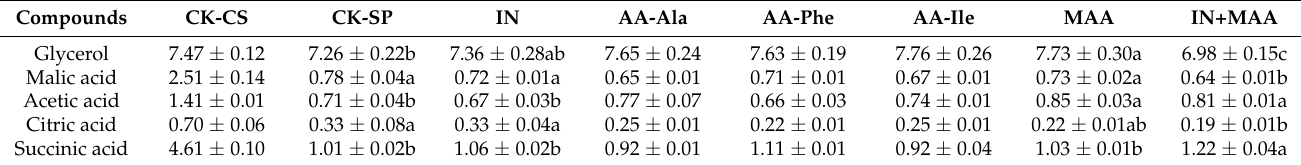
Table 4. Concentrations of extracellular metabolites in wines obtained from different nitrogen nutrient treatments (g/L). Data are mean ± standard deviation. Values displaying different letters within each row are significantly different according to the Duncan test at 95% confidence level. The Duncan test was carried out in columns CK-SP, IN, MAA, and IN+MAA. CK-CS, Cabernet Sauvignon control; CK-SP, spine grape control; IN, DAP supplement; AA-Ala, single alanine supplement; AA-Phe, single phenylalanine supplement; AA-Ile, single isoleucine supplement; MAA, mixed nitrogen supplement with alanine, phenylalanine, and isoleucine; IN+MAA, mixed nitrogen supplement with DAP, alanine, phenylalanine, and